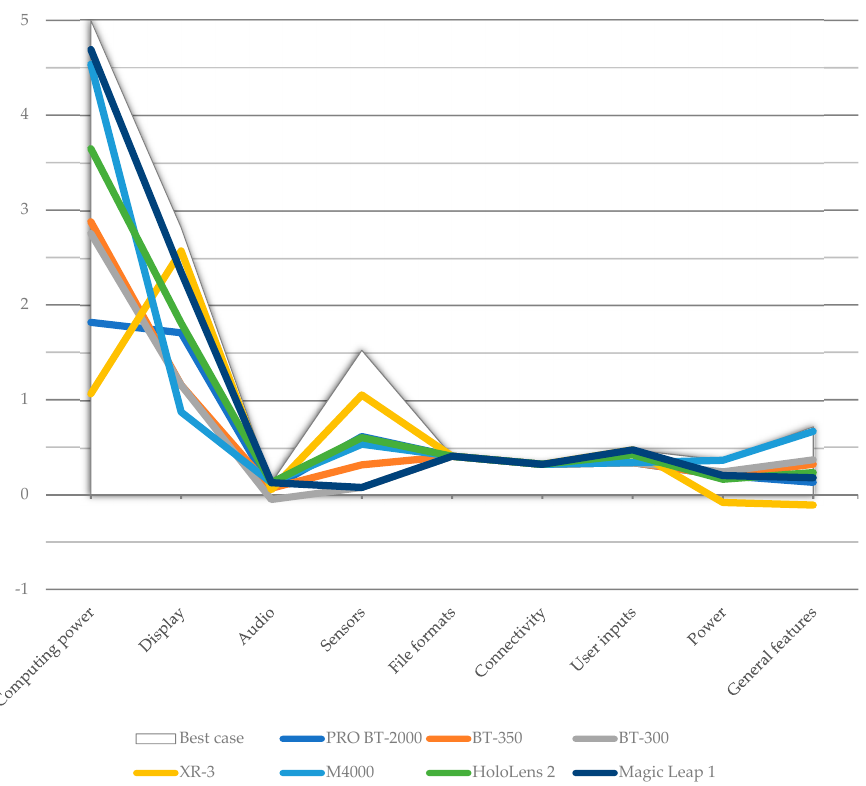
Figure 3 . Devices' evaluation chart for oncological and reconstruction surgery. Figure 3. Devices’ evaluation chart for oncological and reconstruction